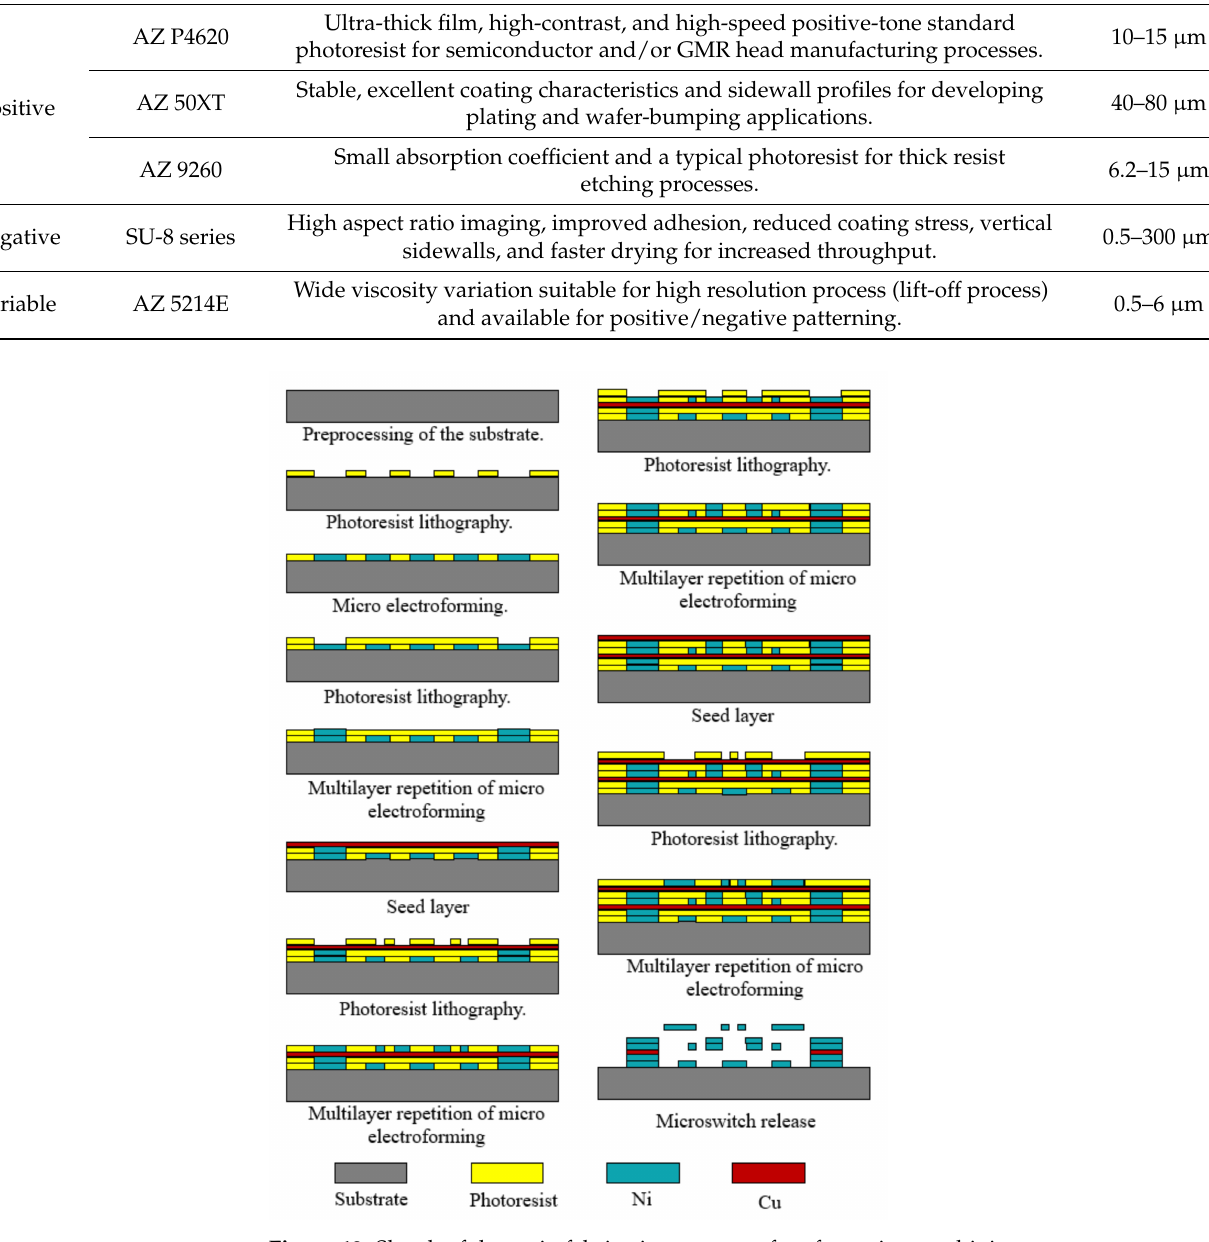
Figure 12. Sketch of the main fabrication process of surface